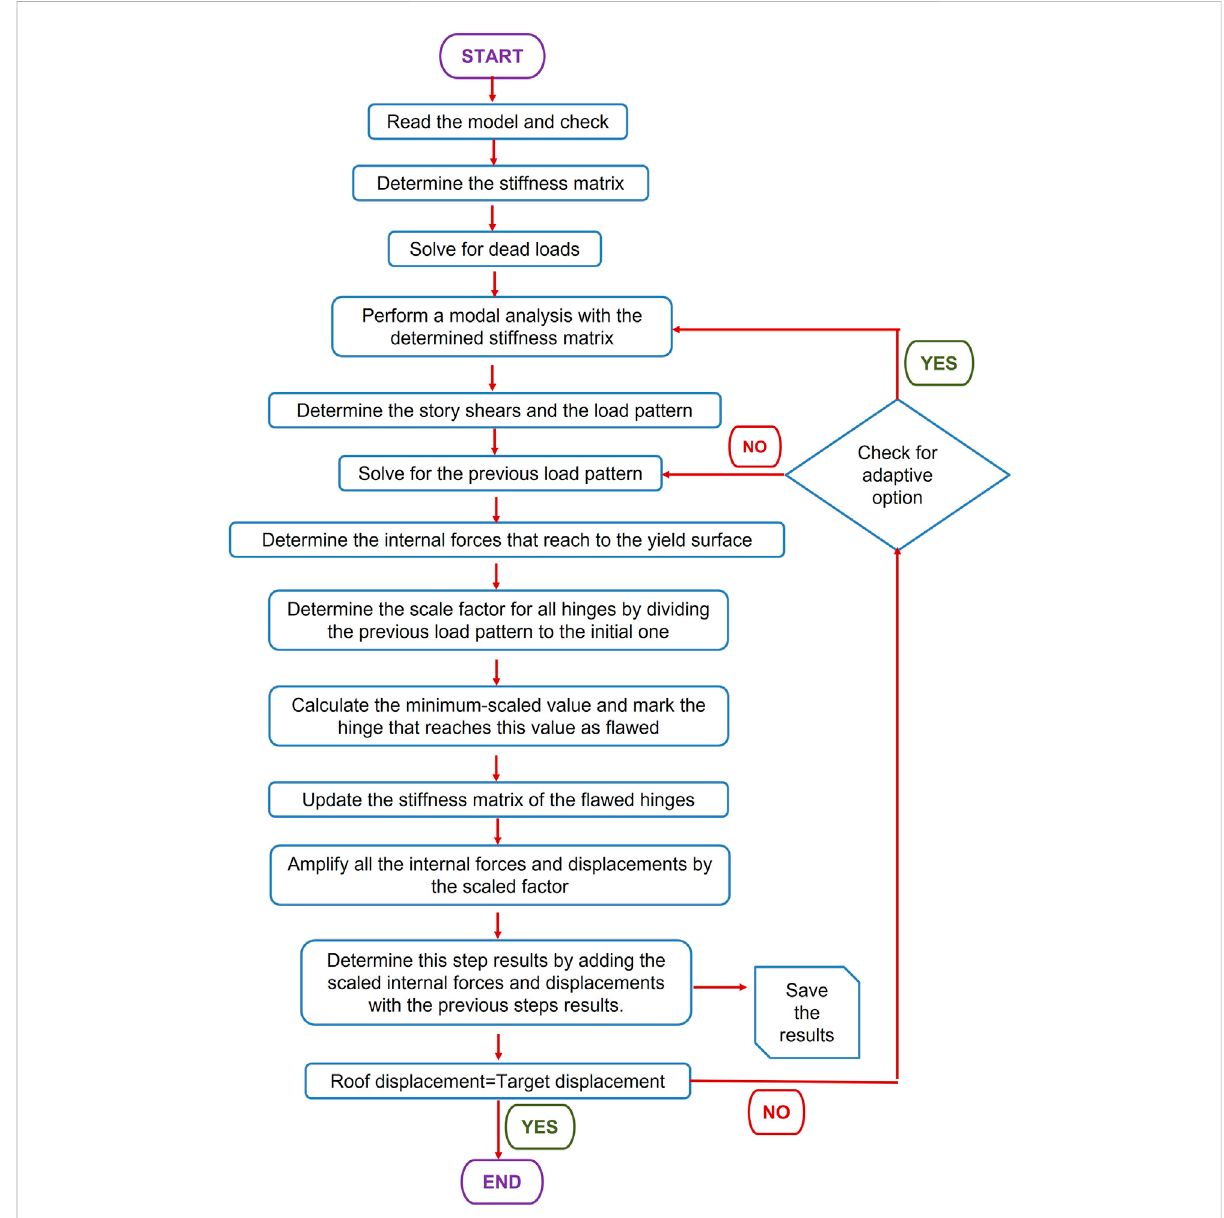
FIGURE 1 Flowchart of the developed code implemented in ZEUS-NL (Elnashai et al., 2002).